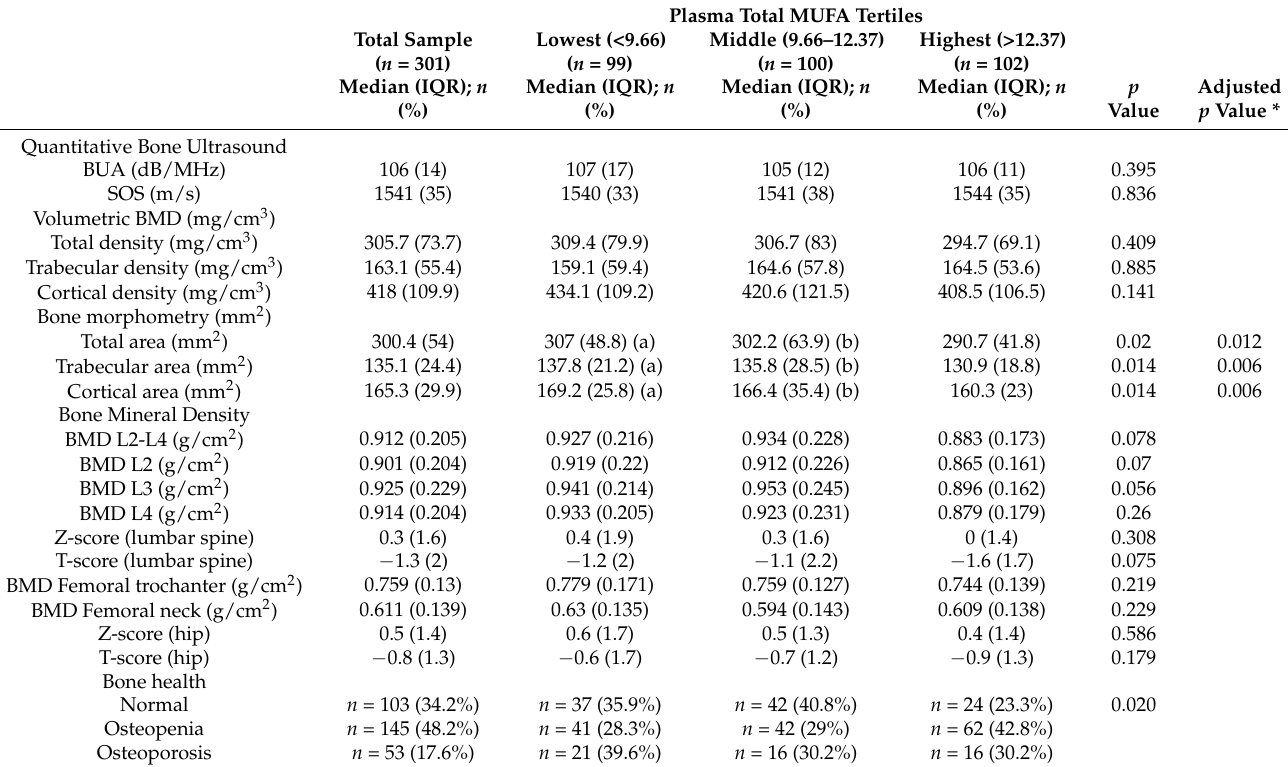
Table 7. Bone parameters by tertile of plasma Monounsaturated Fatty Acids (MUFA) (C16:1 Palmitoleic acid + C18:1 cis (n9) Oleic acid + C22:1 (n9) Erucic